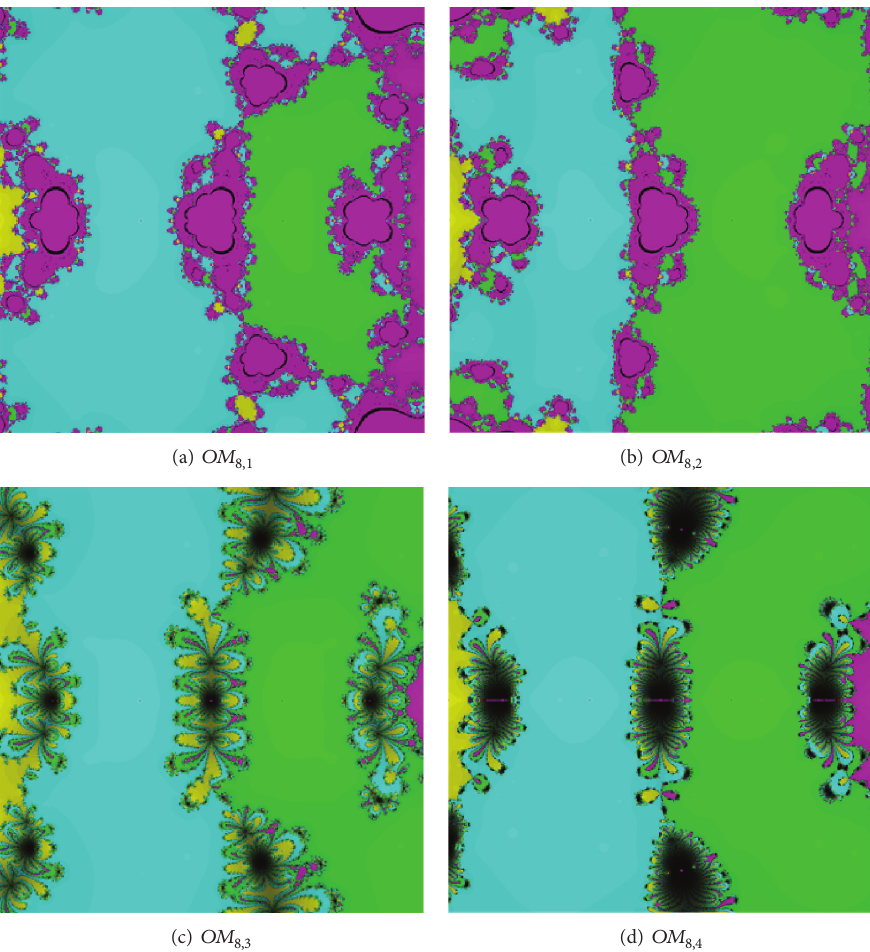
Figure 1: Basins of attraction for polynomial 𝑃 1 (𝑧) = (𝑧 4 − 10𝑧 2 + 9)